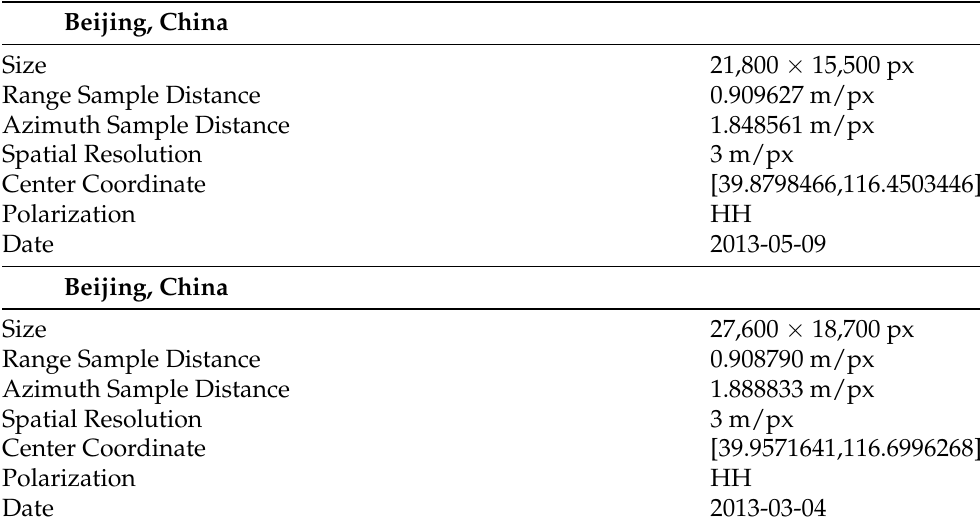
Table 1. Metadata of the TerraSAR-X Images Used in Our Data